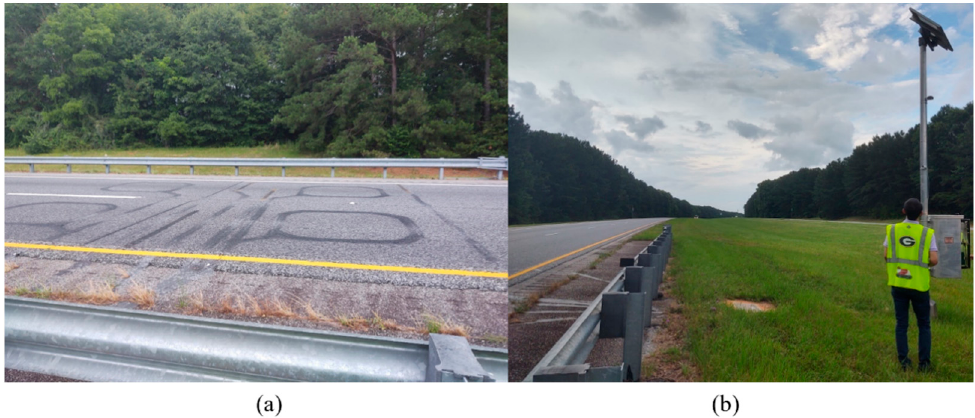
Figure 1. WIM Systems Including ( a ) Weight Sensors Installed on Roadways and ( b ) a Data Acquisition System.